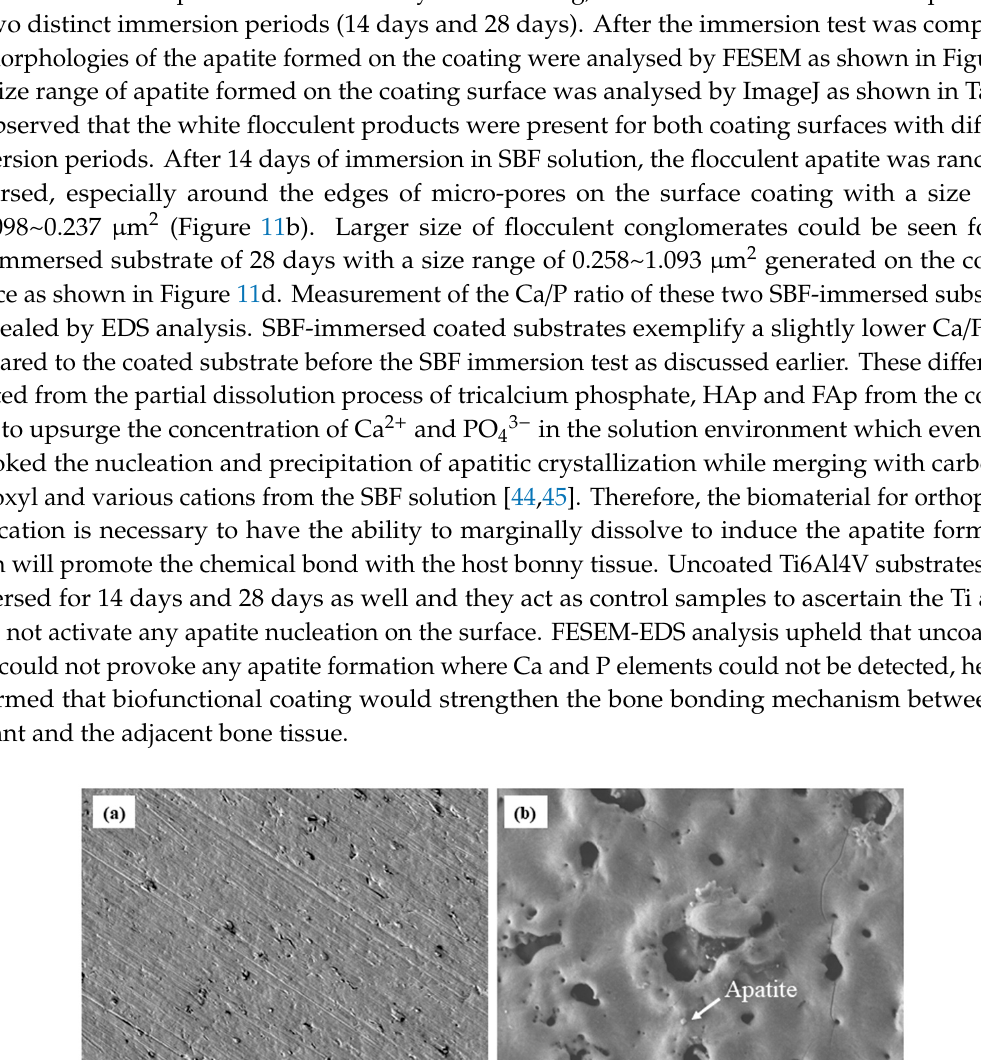
Table 3. Apatite sizes and Ca/P ratio at post-immersion in simulated body fluid (SBF).